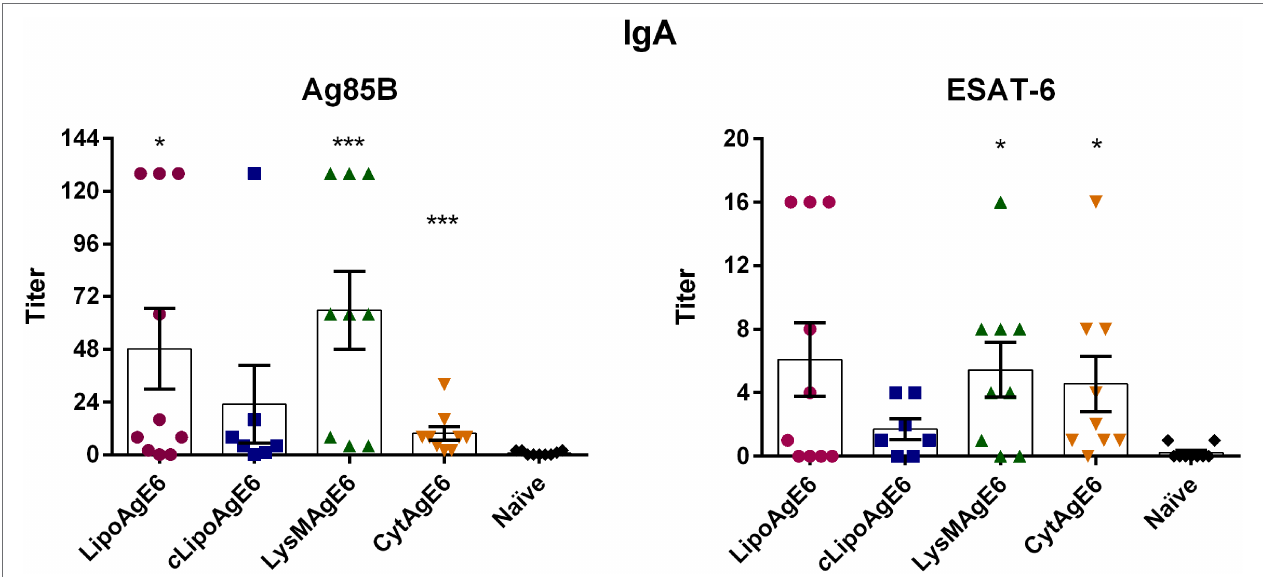
FIGURE 5 | Evaluation of the ability of the four vaccine candidates to induce humoral immunity by analysis of antigen-specific IgA secretion in lung washes. Serial dilutions of lung wash samples (two-fold) were analyzed in an enzyme-linked immunoassay for determination of end-point titers of IgA specific to Ag85B or ESAT-6. Results are presented as a mean ± SEM ( n = 7–10). Statistics were performed on log-transformed data (data not shown) to meet the ANOVA assumptions. Some samples gave a reported value of 0; therefore, a pseudocount of 1 was added to all samples to avoid irrational values upon log10 transformation. Statistically significant differences relative to naïve mice were determined using one-way ANOVA with Games-Howell post-hoc test. * p < 0.05 and *** p <